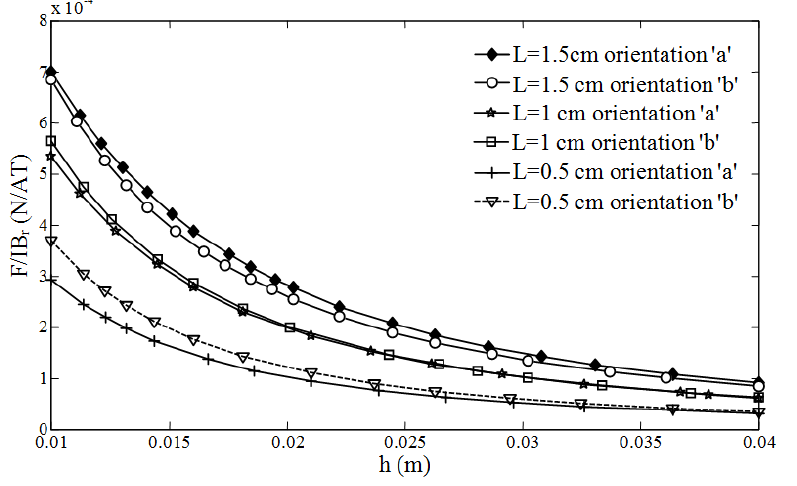
Figure 8. Theoretical force per unit current and unit residual flux density for cylindrical